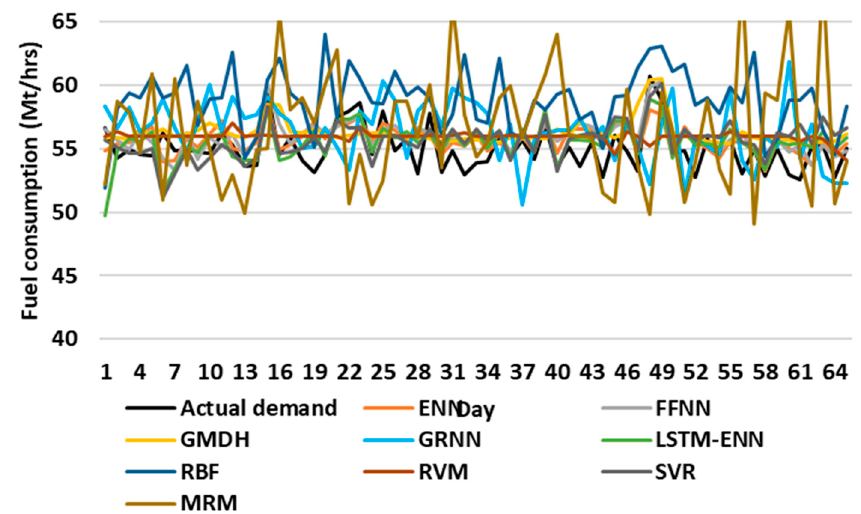
Figure 14. Actual demand and forecasts for Test Case #2.